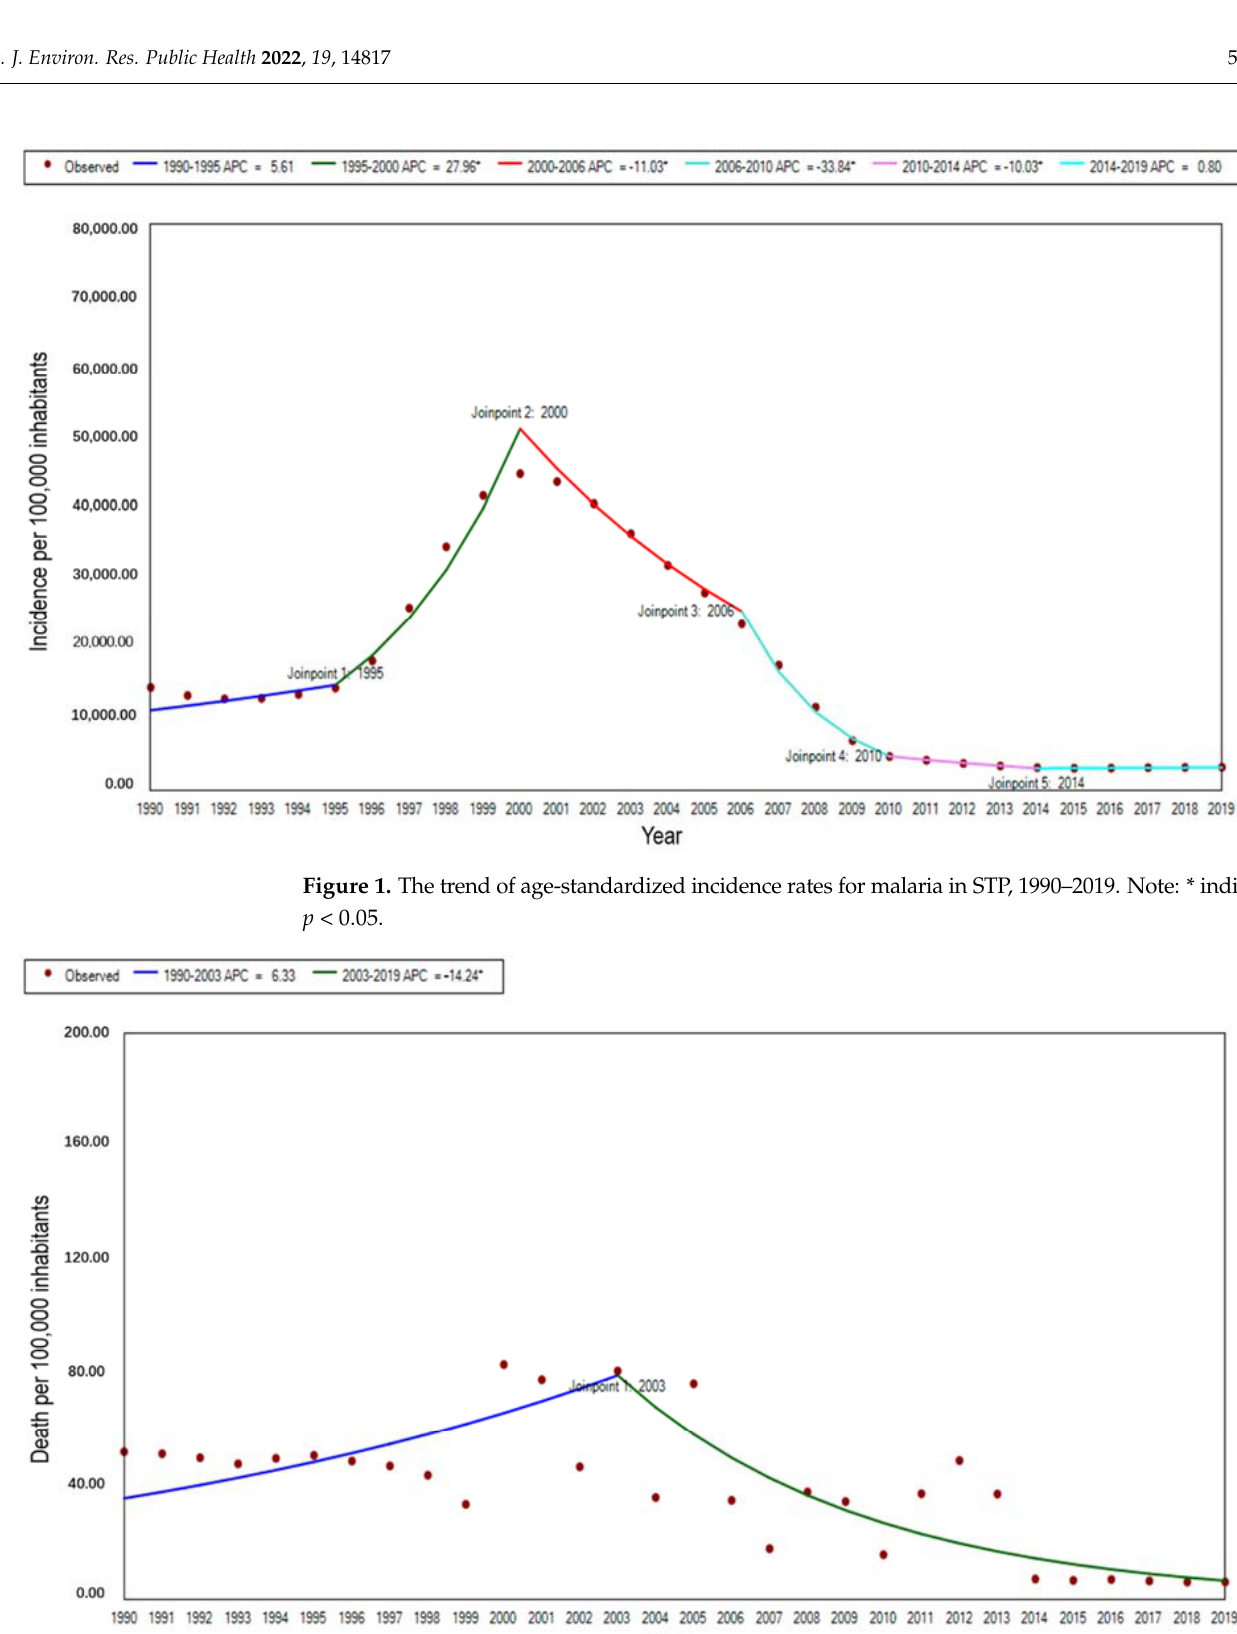
Figure 2. The trend of age ‐ standardized mortality rates for malaria in STP, 1990–2019. Note: * indi ‐ cates p < 0.05.